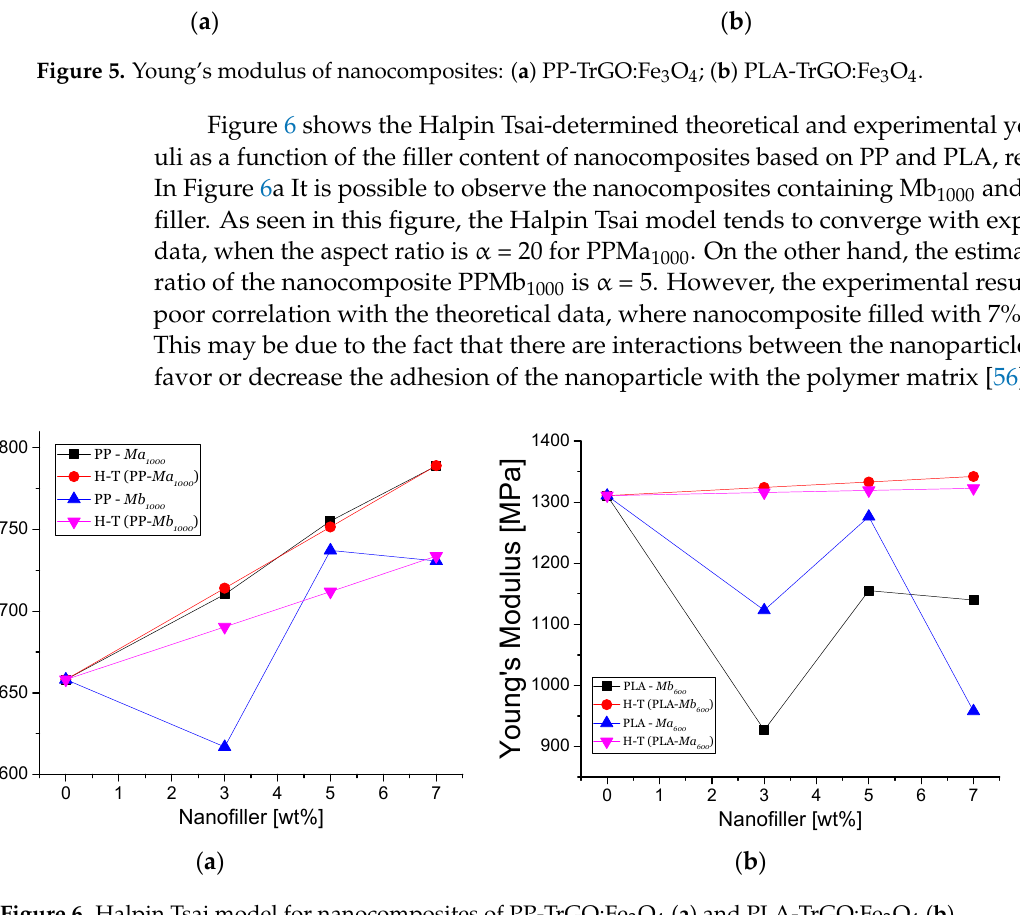
3 O 4 ( a ) and PLA-TrGO:Fe 3 O 4 ( b